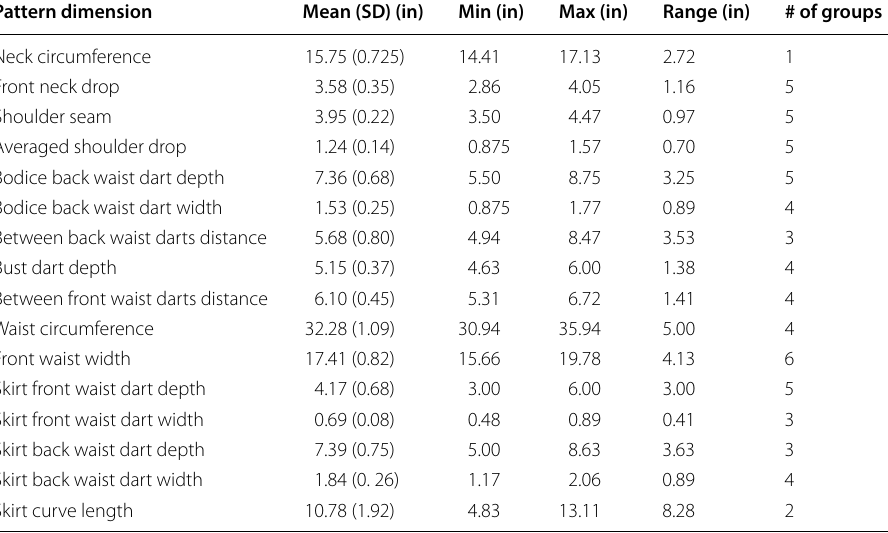
Table 5 Dimensional component descriptive frequencies (in) and number of groups per pattern-block dimension Pattern